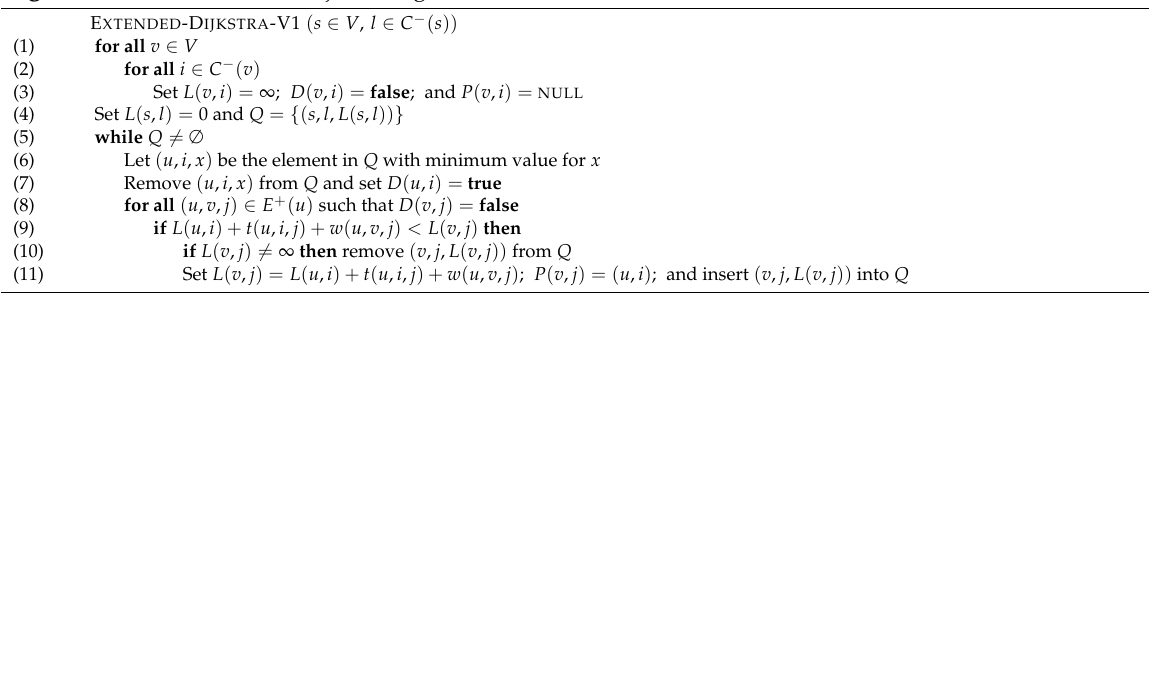
Algorithm 3 The extended Dijkstra algorithm, version